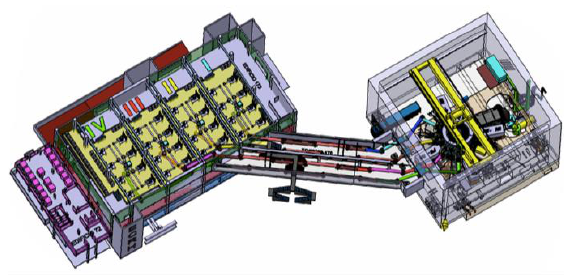
Fig. 1. 3D CAD model of ECRH building (left), THB (right) and the joining bridge